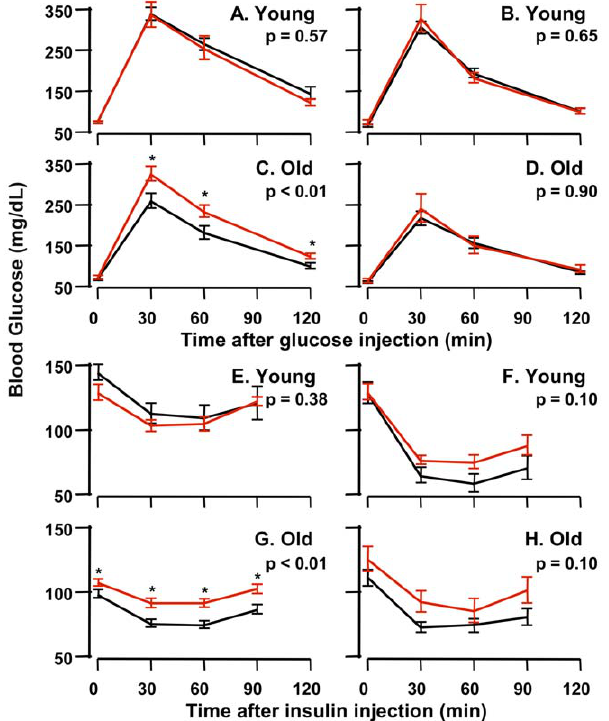
Figure 4. Glucose and Insulin Tolerance Tests. GTTs (2 g/kg, i.p.) were performed in 6-month-old male (A) and female (B) as well as 25- month-old male (C) and female (D) mice after a 12 hr fast, and blood glucose was recorded at times indicated. ITTs (0.5 U/kg, i.p.) were performed in 6-month-old male (E) and female (F) as well as 25-month- old male (G) and female (H) mice after a 5 hr fast. The data were obtained from 6 to 8 animals per group and the SEM is shown. Black lines show the blood glucose levels of WT (black lines) and Igf1r + / 2 mice (red lines). The Student’s t-test was used for the comparisons of the areas under the curve (AUC) and the p-values are shown on each graph. Individual points were also compared in the same manner and corrected for multiple comparisons, and corrected p-values less than 0.05 are denoted by asterisks.